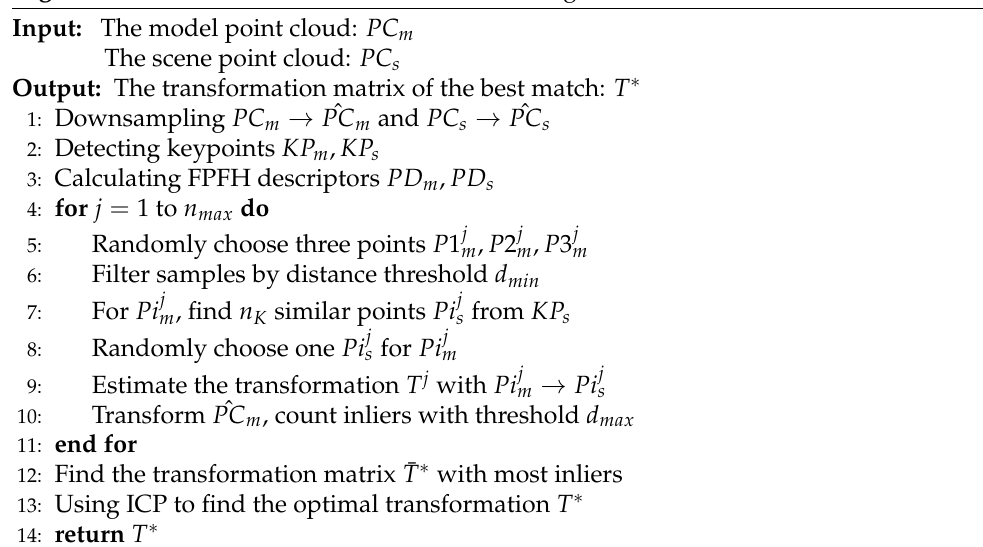
Algorithm 1 Standard SAC-IA Pose Estimation